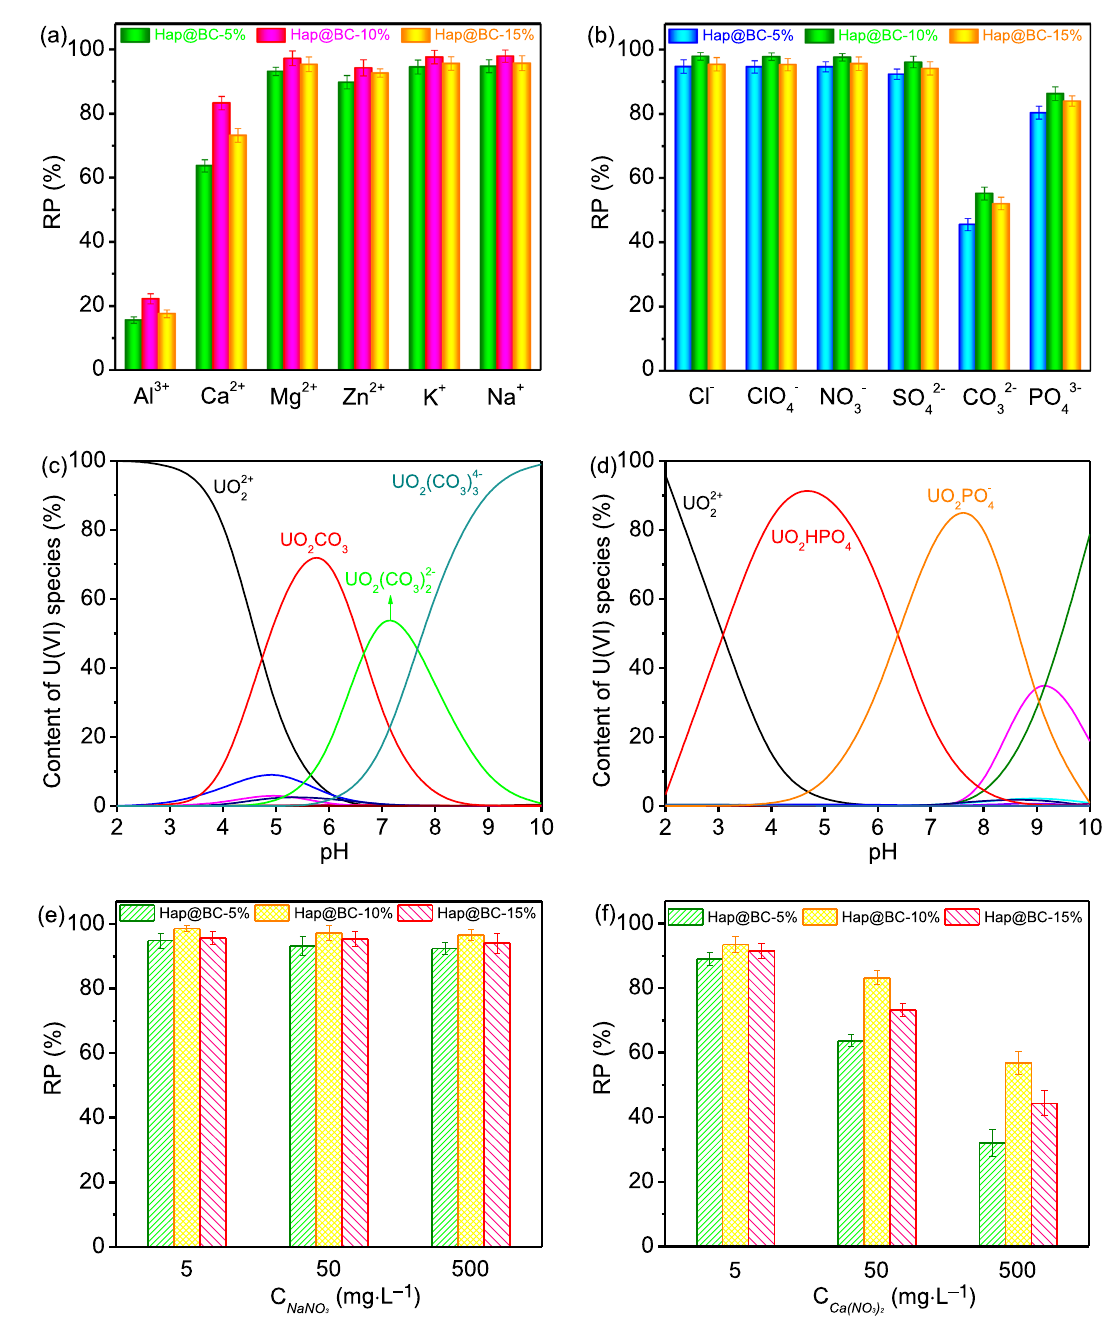
Fig. 3 a Effect of interfering cations on U(VI) removal by Hap@ BC-5%, Hap@BC-10% and Hap@BC-15% (T = 298 K, pH = 3, m/V = 0.1 g/L and C i = 5 mg/L), b Effect of co-existing anions on U(VI) removal by Hap@BC-5%, Hap@BC-10% and Hap@BC-15% (T = 298 K, pH = 3, m/V = 0.1 g/L and C i = 5 mg/L), c Effect of CO 32− (50 mg/L) on the existing forms of U(VI) species (C i = 5 mg/L and T = 298 K), d Effect of PO 43− (50 mg/L) on the existing forms and b, it was quite clear that the influence of interfering ions on the U(VI) removal of Hap@BC-5%, Hap@BC-10% and Hap@BC-15% was comparatively weak, suggesting that